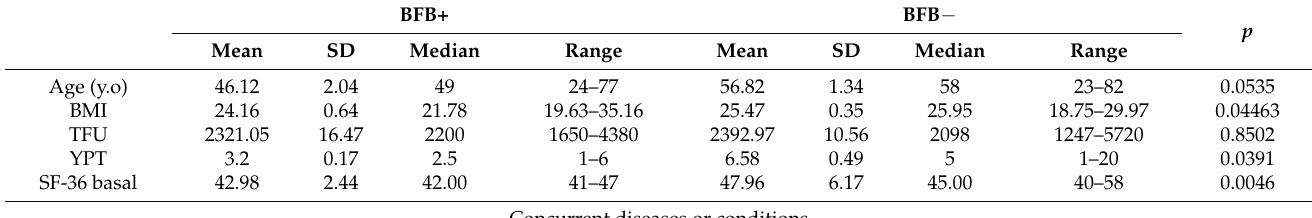
Table 1. Characteristics of the patients in BFB+ and in BFB −